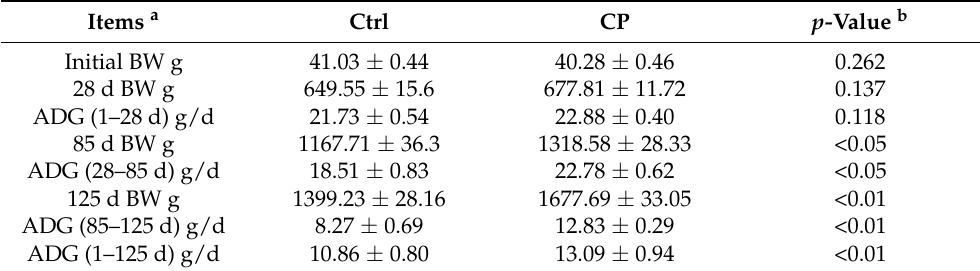
Table 2. Effects of compound probiotics on growth performance of